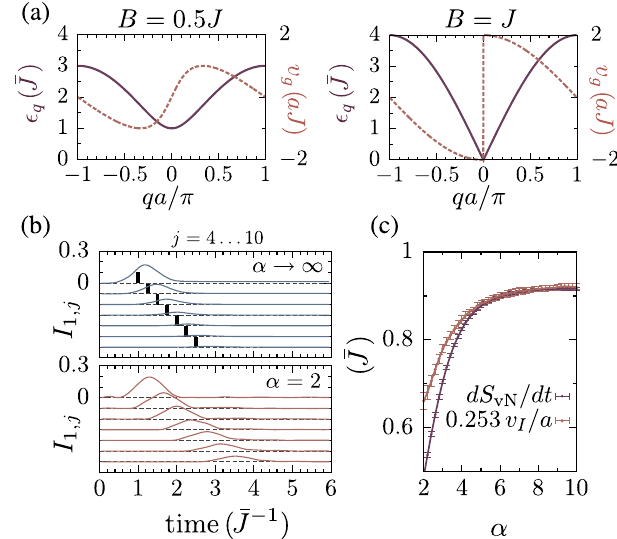
FIG. 7. (a) Quasiparticle dispersion relations for the nearest- . The neighbor Ising Hamiltonian for B ¼ 0 and B ¼ J , (cid:5) q ð q Þ =a ¼ d(cid:5) =d ð qa Þ are shown corresponding group velocities v g q as dashed lines (right axis). (b) The time evolution of the mutual between the leftmost spin and j ¼ 4 ; . . . ; 10 information I 1 ;j (ED, B ¼ 1 , M ¼ 20 ; different I offset by (cid:2) 0 : 1 for different 1 ;j j , for better visibility). The upper panel is for (cid:1) ! 1 (nearest- neighbor interactions), the lower panel for (cid:1) ¼ 2 . The vertical black bars indicate the analytical result of the entangled quasi- particle pair arrival, calculated from the group velocity. (c) The half-chain entropy growth rates (linear fit 1 < t (cid:1) J < 3 , ED, B ¼ 1 , M ¼ 20 ) compared to the effective velocity of the entangling (see text). We extract v from a linear ‘‘quasiparticle wave’’ v I I fit to the position of the mutual information peaks in panel ¼ arrives at both spins, this time is given by t j ð j (cid:2) 2 Þ = 2 v ¼ ð j (cid:2) 2 Þ = 2 a (cid:1) J and is shown as black bars R